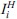
Schematic representation of the pathogen life cycle.In our model we assume that hosts can either be uninfected or infected by the wild type (in green) or a mutant genotype (in red). Transmission can take two different routes. Horizontal transmission occurs between a susceptible host and an infected host with genotype i with rate β
i[I|S] (see supporting information Theory in S1 Text). Vertical transmission occurs when and infected host reproduces in an empty site with rate b
I
δq
0/i, where b
I is the reproduction rate of infected hosts, δ is the fidelity of vertical transmission and q
0/i measures the average local density of empty sites around hosts infected with genotype i. Among hosts infected by the same genotype we distinguish hosts that got infected horizontally (noted IiH) or vertically (noted IiV). Both types of hosts can reproduce and have an increased mortality rate α
i (i.e. virulence) due to the infection with genotype i.